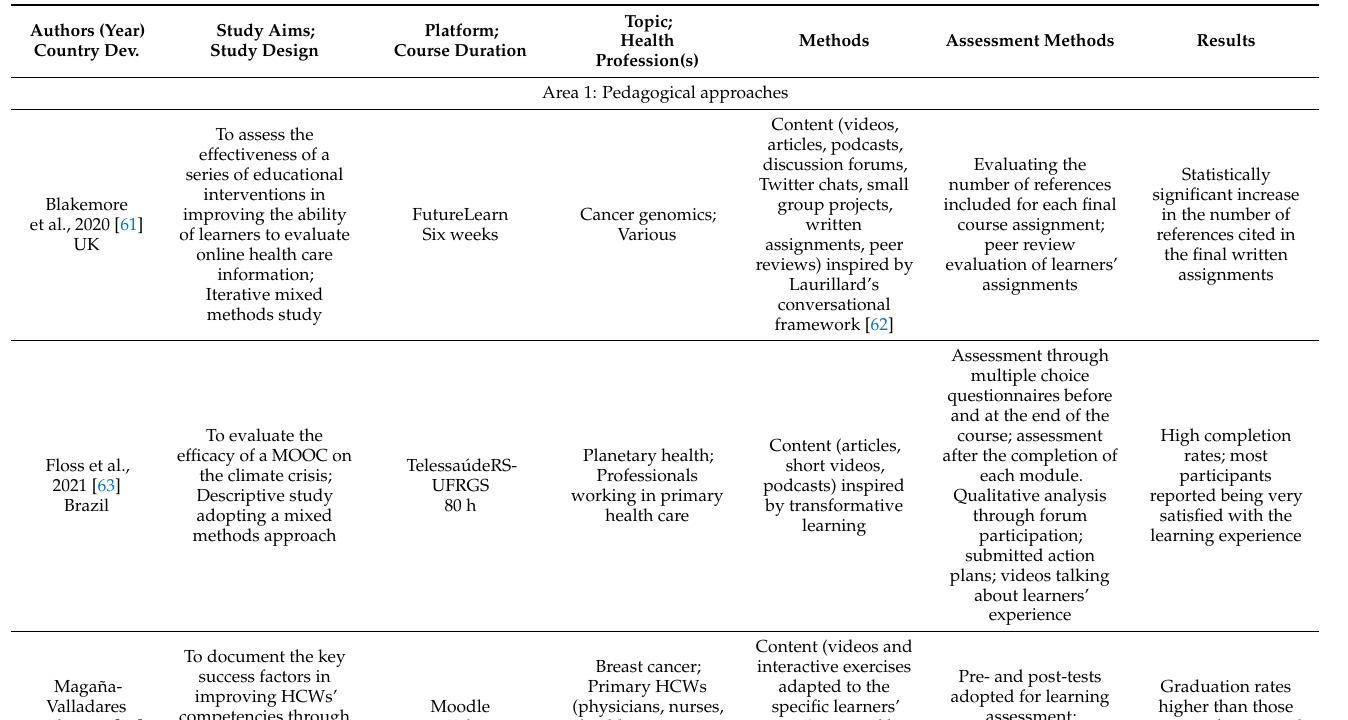
Table 1. Summary of the articles included in the scoping